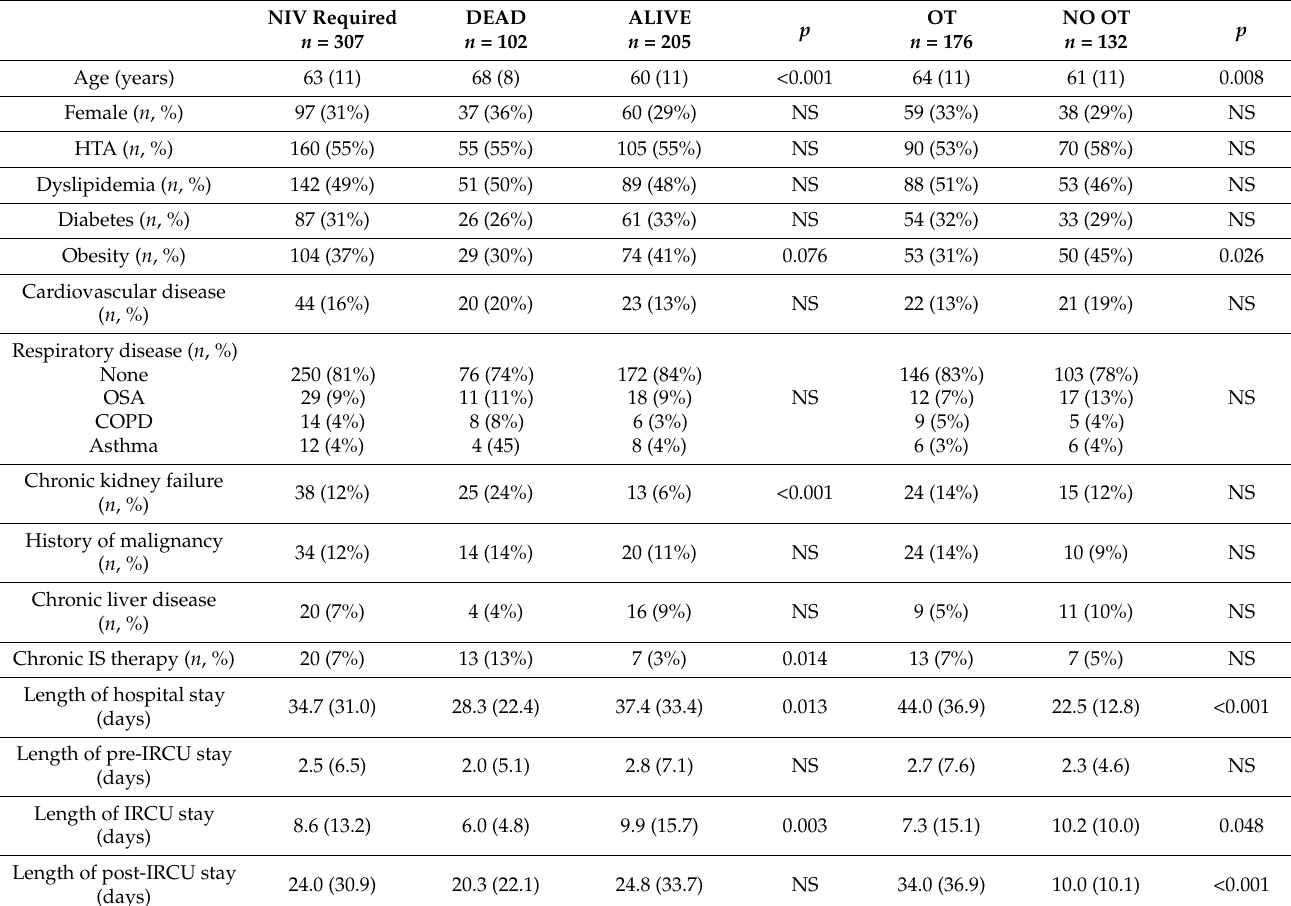
Table 2. Comparison depending on survival and intubation status in the NIV group: patients with severe hypoxemic respiratory. OT, oral intubation; HTA, arterial systemic hypertension; OSA, ob- structive sleep apnea; COPD, chronic obstructive pulmonary disease; IS therapy, immunosuppressive therapy; IRCU, intermediate respiratory care unit; ICU, intensive care unit; SaFiO 2 , oxygen saturation by pulse oximetry divided by inspired oxygen fraction; PaFiO 2 , partial arterial pressure of oxygen di- vided by inspired oxygen fraction; LDH, lactate dehydrogenase; RR, respiratory rate; PaCO 2 : partial arterial pressure of carbon dioxide; NRT, non-invasive respiratory therapy; HFNC, high flow nasal cannula; NIV, non-invasive ventilation; FiO 2 , inspired oxygen fraction; IPAP, inspiratory